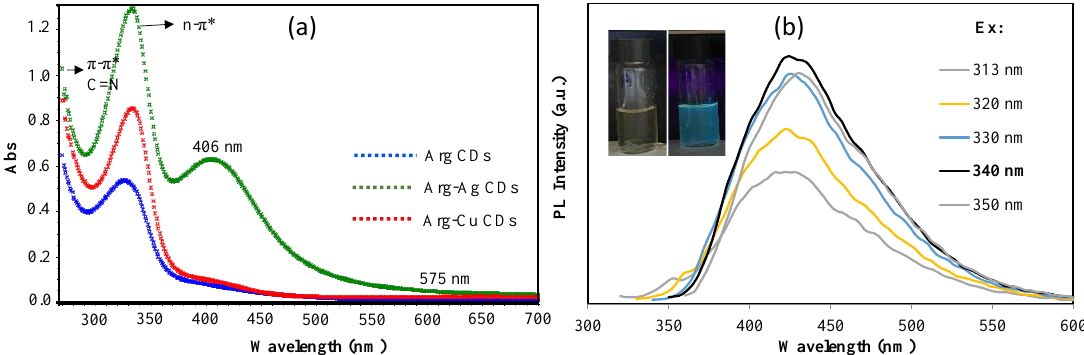
Figure 5. ( a ) UV-Vis absorption spectrum of Arg CD, Arg-Ag CD, and Arg-Cu CD solutions and ( b ) Digital camera images of the Arg CD solution under ambient light and ultraviolet light at 254 nm and its fluorescence spectra at different excitation wavelengths.